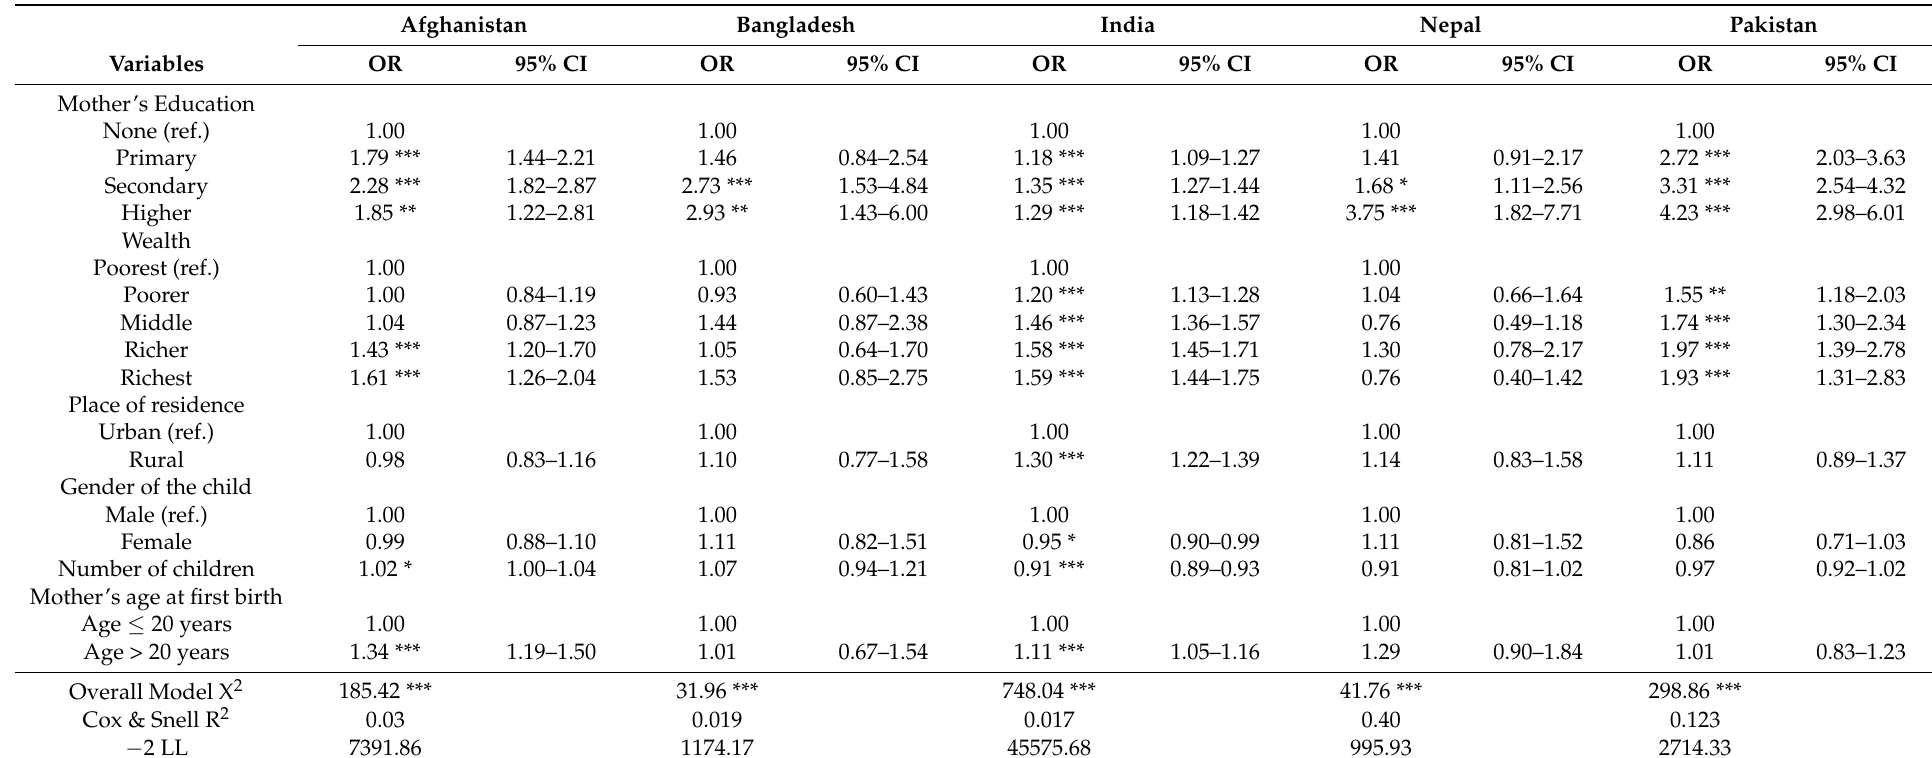
Table 2. Results from logistic regression analysis of full immunisation in South Asian countries. Afghanistan